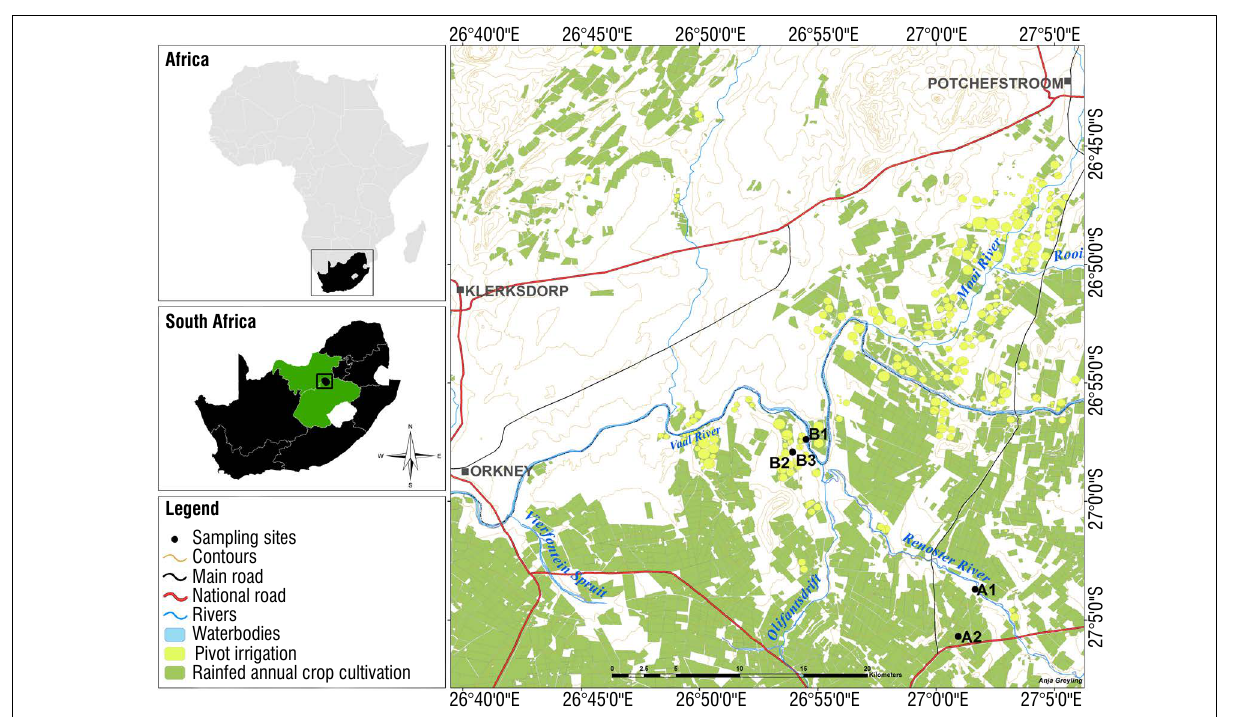
Figure 1: Map of the sampling sites situated on Farms A and B. A1: Renoster River; A2: water from a farm dam; B1: Vaal River; B2: inflow dam; B3: water from a farm